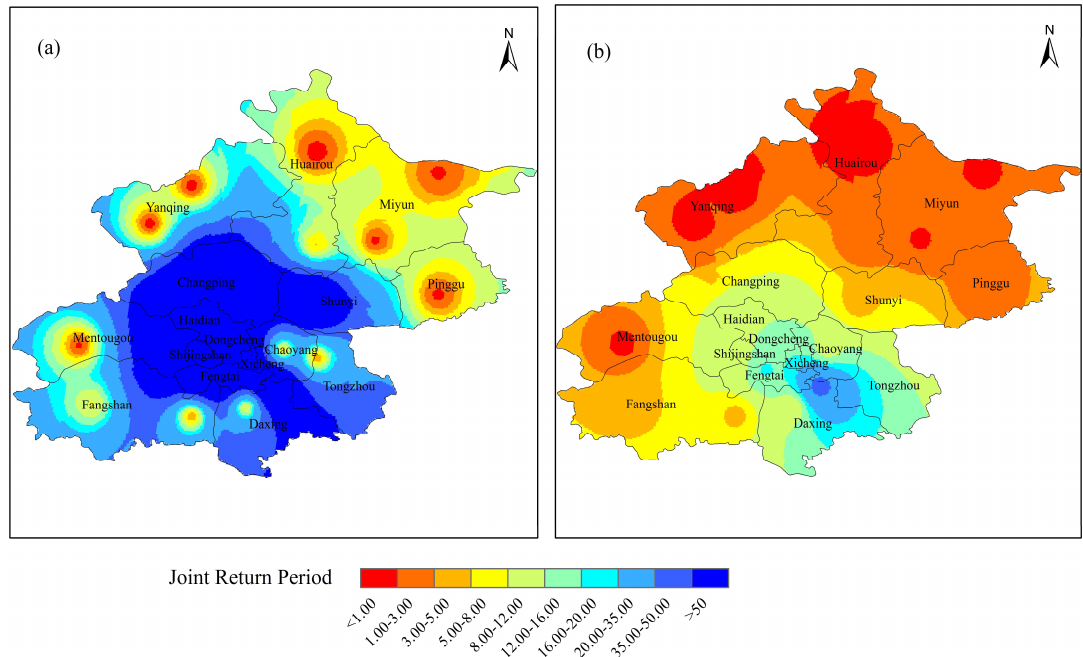
Figure 9. Spatial distributions of joint return periods for extreme low temperature events the study periods: ( a ) 1978–1998; ( b ) 1999–2015 (unit: year). Atmosphere 2018 , 9 , x FOR PEER REVIEW